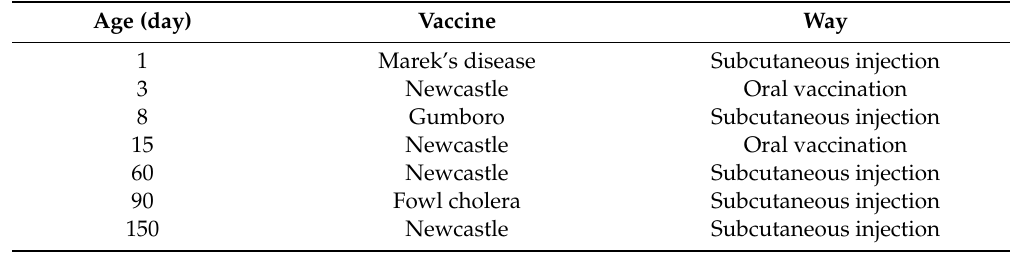
Table 2. Vaccination protocol for Ho and Dong Tao